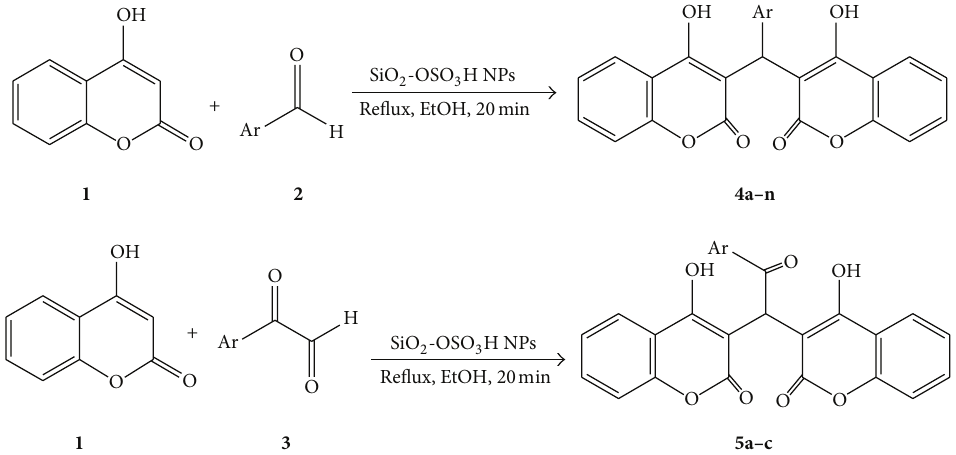
Scheme1:Synthesisofbiscoumarinsbycondensationof4-hydroxycoumarinwithanaromaticaldehydeorphenylglyoxalsusingSiO 2 -OSO 3 H NPs as